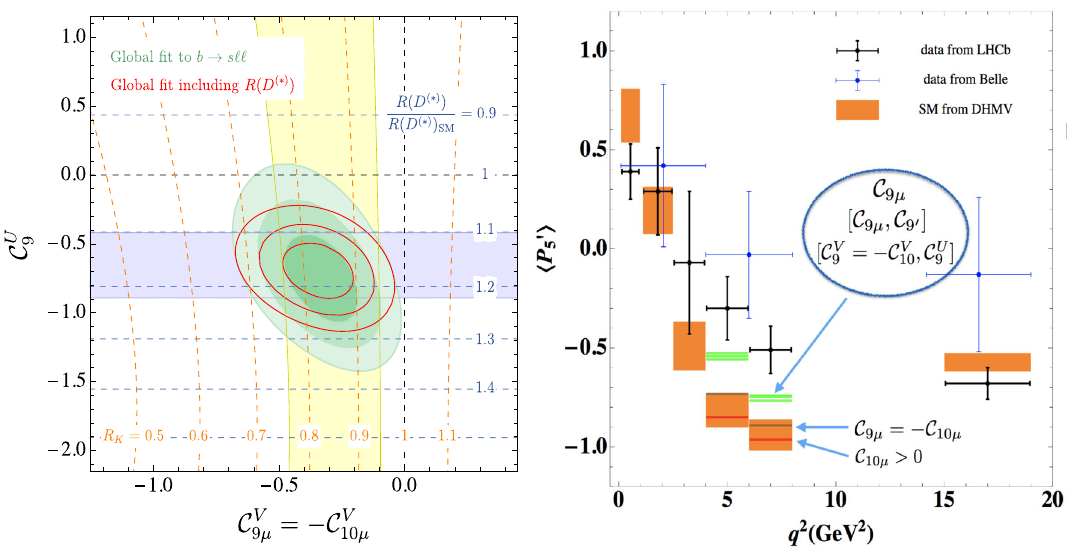
Fig. 5 Left: preferred regions at the 1, 2 and 3 σ level (green) in the ( C V = − C V , C U ) plane from b → s (cid:2) + (cid:2) − data. The red contour 9 μ 10 μ 9 lines show the corresponding regions once R D ( ∗ ) is included in the fit (for (cid:8) = 2 TeV). The horizontal blue (vertical yellow) band is con- sistent with R D ( ∗ ) ( R K ) at the 2 σ level and the contour lines show the